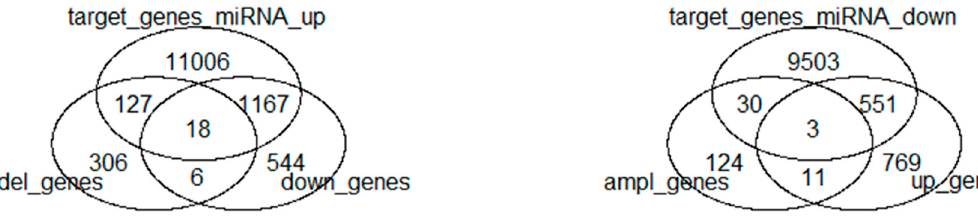
Figure 1. Venn diagram for the integrative approaches.